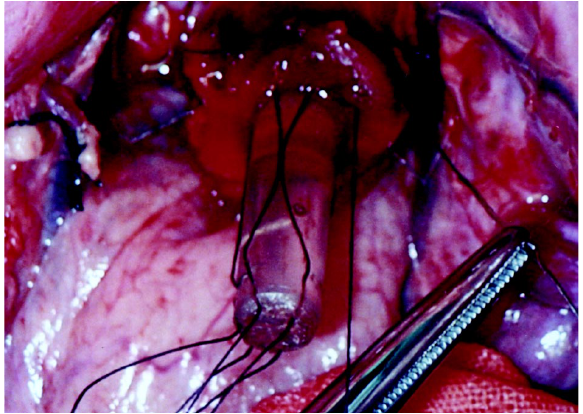
Figure 7 – Needle traction for passing the stitch. Figure 8 – First stitch passed.